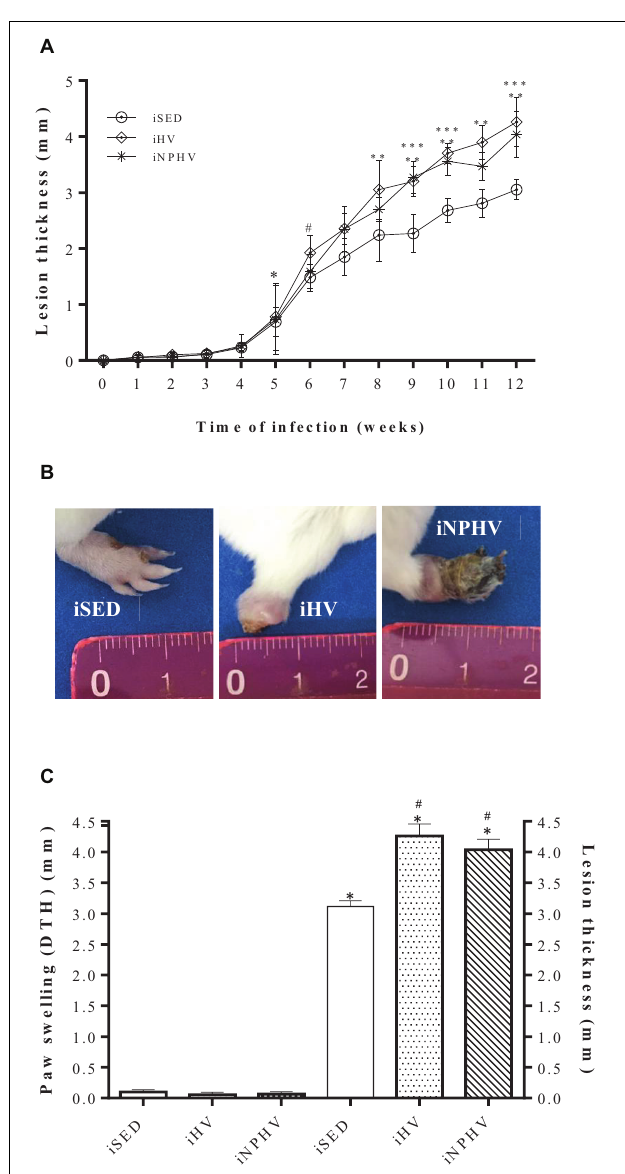
FIGURE 4 | Effect of physical exercise on the development of the paw lesion in a BALB/c mouse infected with L. major (2 × 10 6 promastigotes). (A) The paws were measured weekly with the aid of a caliper (Mitutoyo). The expressed results represent the difference between the measure of the contralateral paw (mm) and the infected paw, during 12 weeks of training with in vivo infection. Values represent the mean of the animals in each group and the bars represent the standard error. The ∗ indicates from which week the lesion became significant for iHV and iNPHV (5th week) and the # indicates from which week the lesion became significant for iSED (6th week). ∗∗ iHV with P < 0.0001 in relation to sedentary control (iSED) from the 8th week. ∗∗∗ iNPHV with P < 0.0001 compared with sedentary control (iSED) in weeks 9, 10, and 12. (B) Photographs are representative of one animal from each group. Photographs taken in the 13th week. (C) Comparison between DTH (48 h) and lesion thickness in paws after 12 weeks of L. major infection. ∗ P < 0.0001 in relation to the respective DTH values. # P < 0.0001 in relation to the size of the sedentary control lesion. Groups: infected sedentary control (iSED), infected high volume (iHV), and infected non-periodized high volume